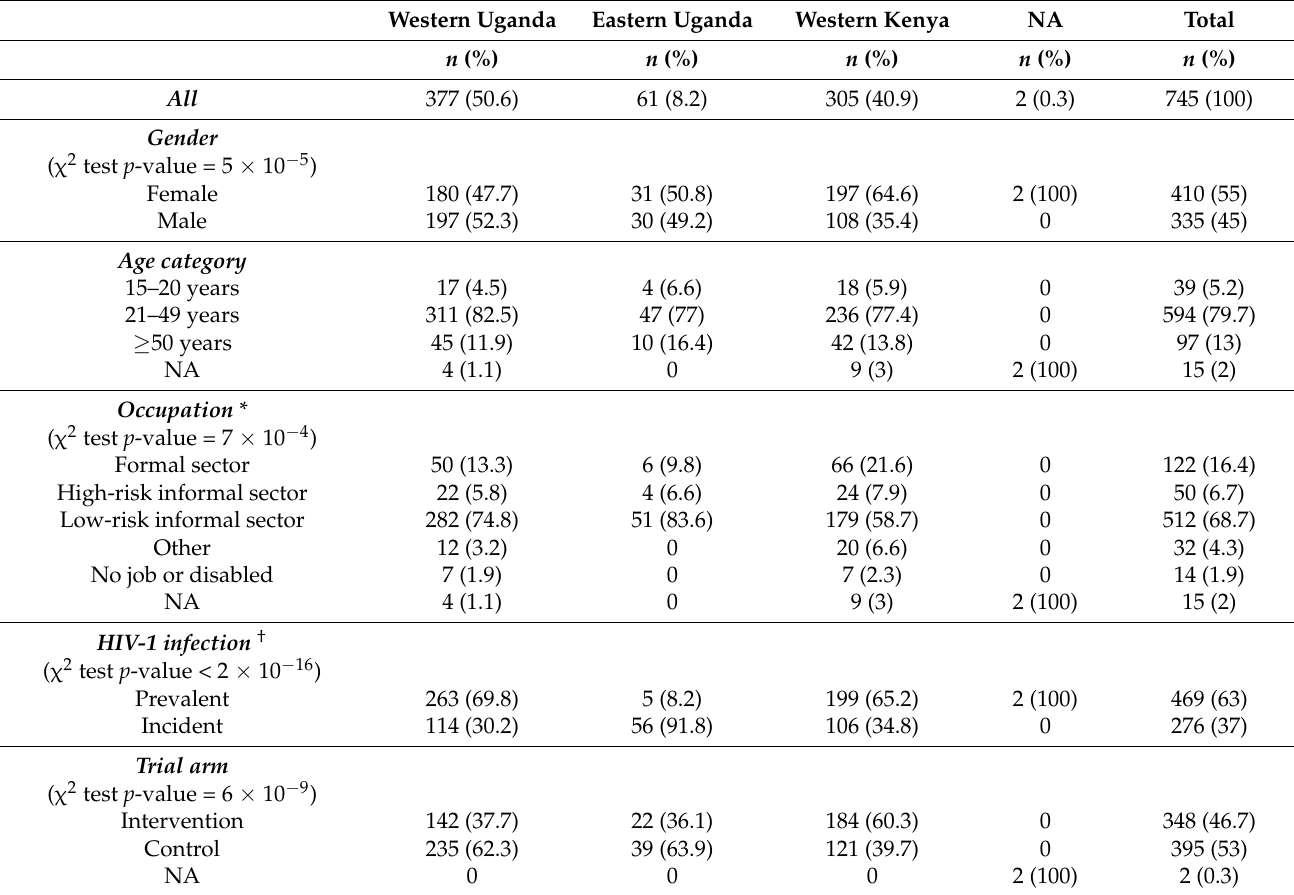
Table 1. Characteristics of sequenced SEARCH trial participants by geographical region ( n = 745). Western Uganda Eastern